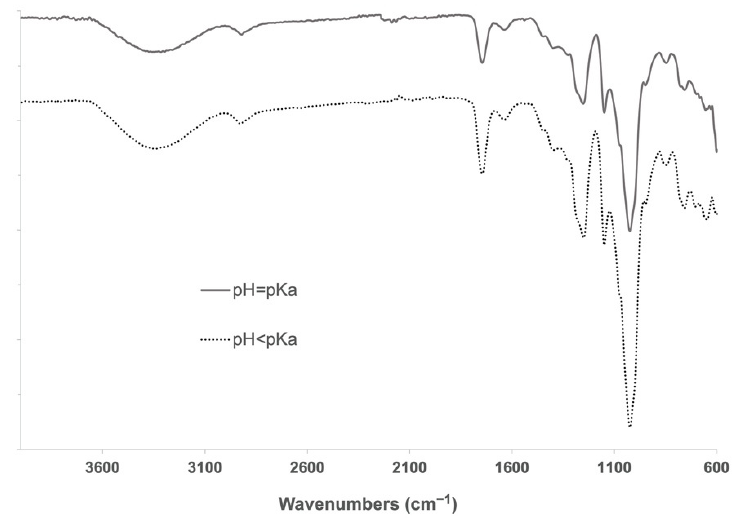
Figure 8. FTIR-ATR spectra of α -CD-NS washed at pH 6.9 (solid line) and pH 6.0 (dotted line). The band of interest at around 1750 cm − 1 assignable to the carbonyl group was visible in both samples.